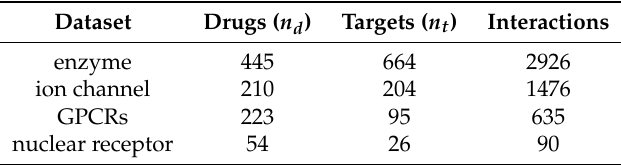
Table 1. Datasets provided by Yamanishi et al. [9].